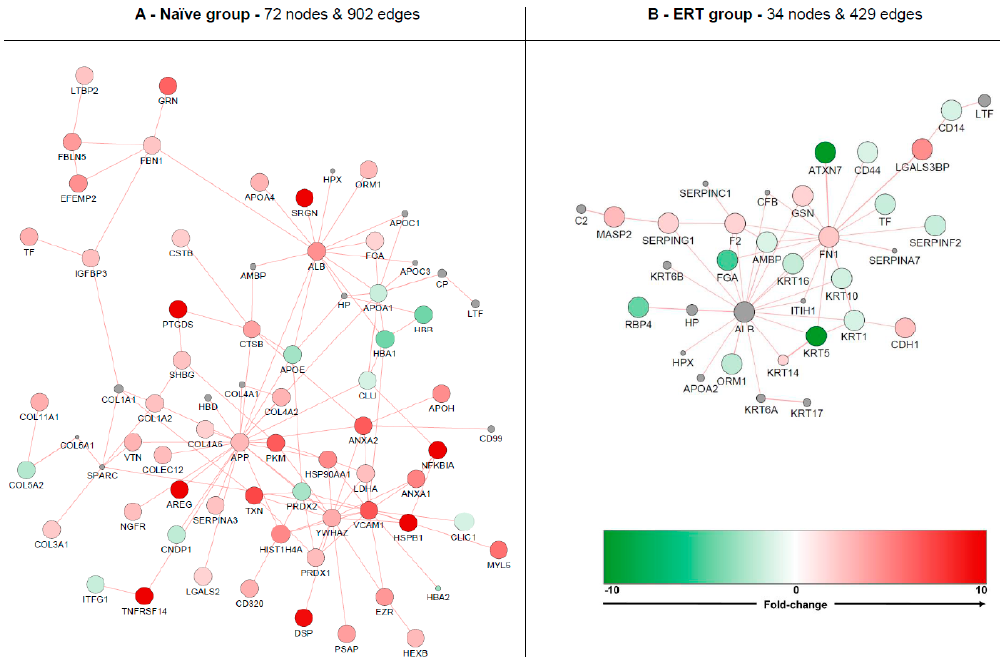
Figure 6. Molecular clustering based on protein-protein interactions (PPIs). Red node colour denotes an increased expression of the protein and green a decrease. Nodes displaying grey colour represent enriched molecules from GeneMania. Analysis was based on naive ( A ) and ERT groups ( B ). Isolated nodes and small clusters (with less than three molecules bonding) were removed in order to highlight only relevant network features. Globally, the naïve group formed an up-regulated cluster containing 72 nodes and 902 edges. The ERT group formed a down-regulated cluster containing 34 nodes and 429 edges. The most up-regulated molecules for the naïve group cluster are serglycin (SRGN), prostaglandin-H2 D-isomerase (PTGDS), amphiregulin (AREG), tumor necrosis factor receptor superfamily member 14 (TNFRSF14), desmoplakin (DSP), heat shock protein beta-1 (HSPB1) and NF-kappa-B inhibitor alpha (NFKBIA). The most down-regulated molecules for the ERT group cluster are ataxin-7 (ATXN7) and keratin type II cytoskeletal 5 (KRT5). An enriched network with PPIs for Fabry disease containing additional data from DisGeNET can be found in Supplementary Figure S6.